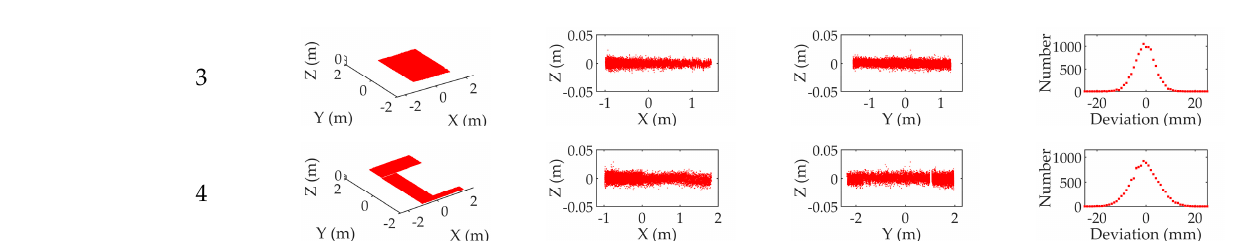
Figure A2. The evaluation of the shape accuracy of the 3D point clouds obtained by our prototype in 7 modes.